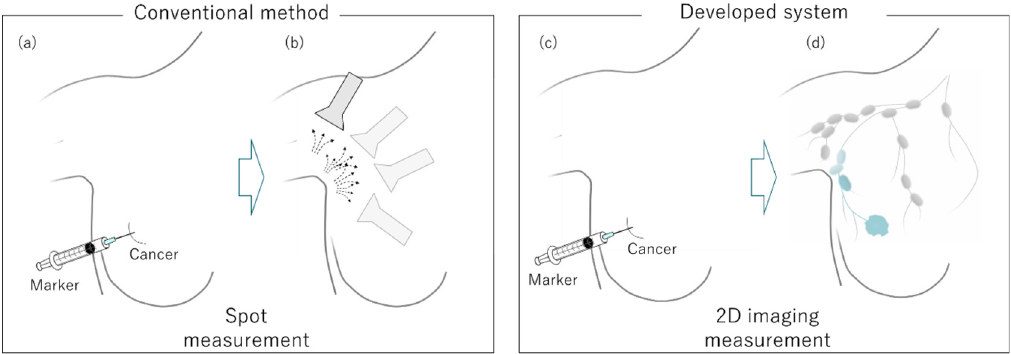
Figure 1. Methods of the sentinel lymph node identification. The position of a tracer injected into a breast cancer ( a ) in the conventional method is manually detected with a detector by the location of the sentinel lymph node ( b ). According to the proposed method, magnetic particles are injected as a tracer to the breast cancer ( c ), and then the spatial distribution of the magnetic particles is determined by a two-dimensional scan with a magnetic sensor ( d ).